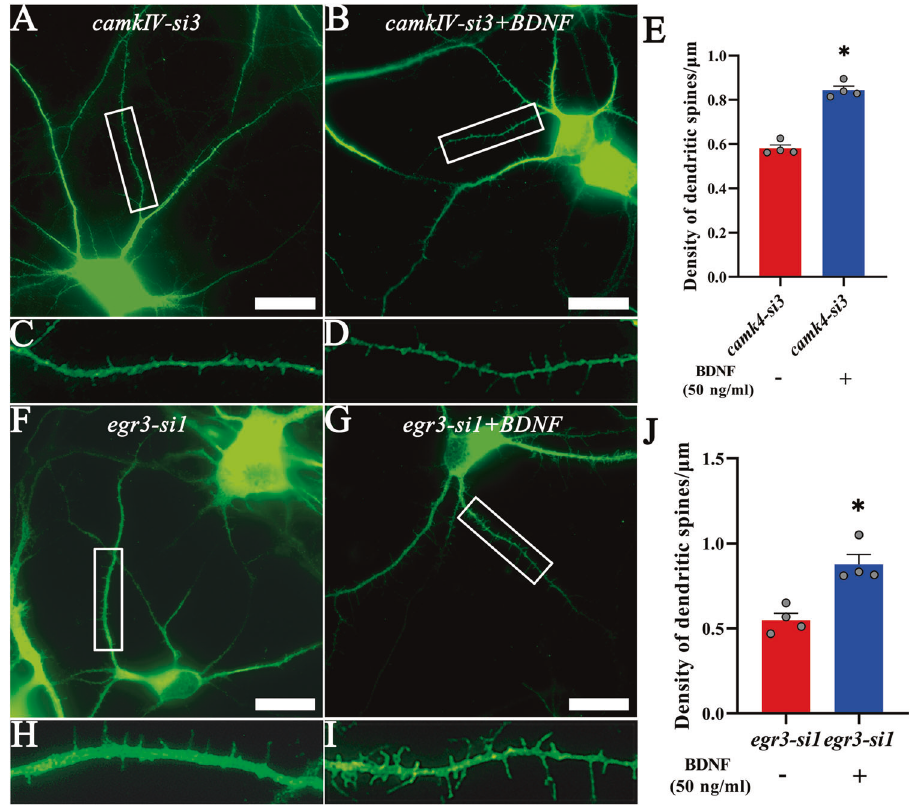
Fig. 8 BDNF rescued the growth of dendritic spines following the knockdown of CaMKIV/EGR3. A – D , F – I The primary hippocampal neurons were transfected with camk4- Si3 and egr3- Si1 and cultured for 5 days, then supplemented with 50 ng/ml BDNF for 24 h, the density of dendritic spines was detected by immuno fl uorescence staining with MAP2 antibody. The rectangle indicates the magni fi ed region. E , J Statistical analysis of spine density in quadruplicates every 15 fi elds. Scale bar: 20 μ m. Error bars represent the standard error (* P <